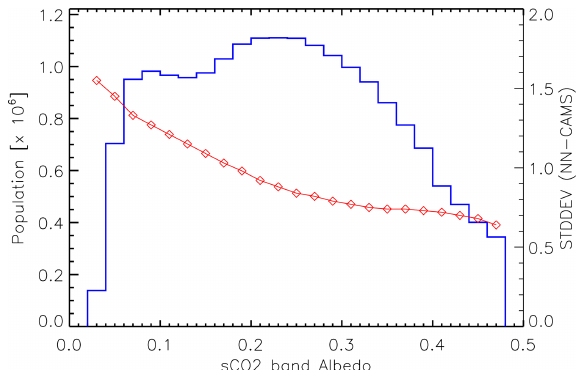
Figure 6. Standard deviation of the NN–CAMS difference as a function of the sCO2 band albedo (red, right scale). The compu- tation is made over 0.02 bins, the population of which is shown by the blue line (left